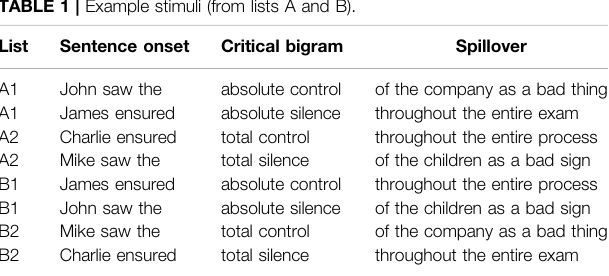
TABLE 1 | Example stimuli (from lists A and